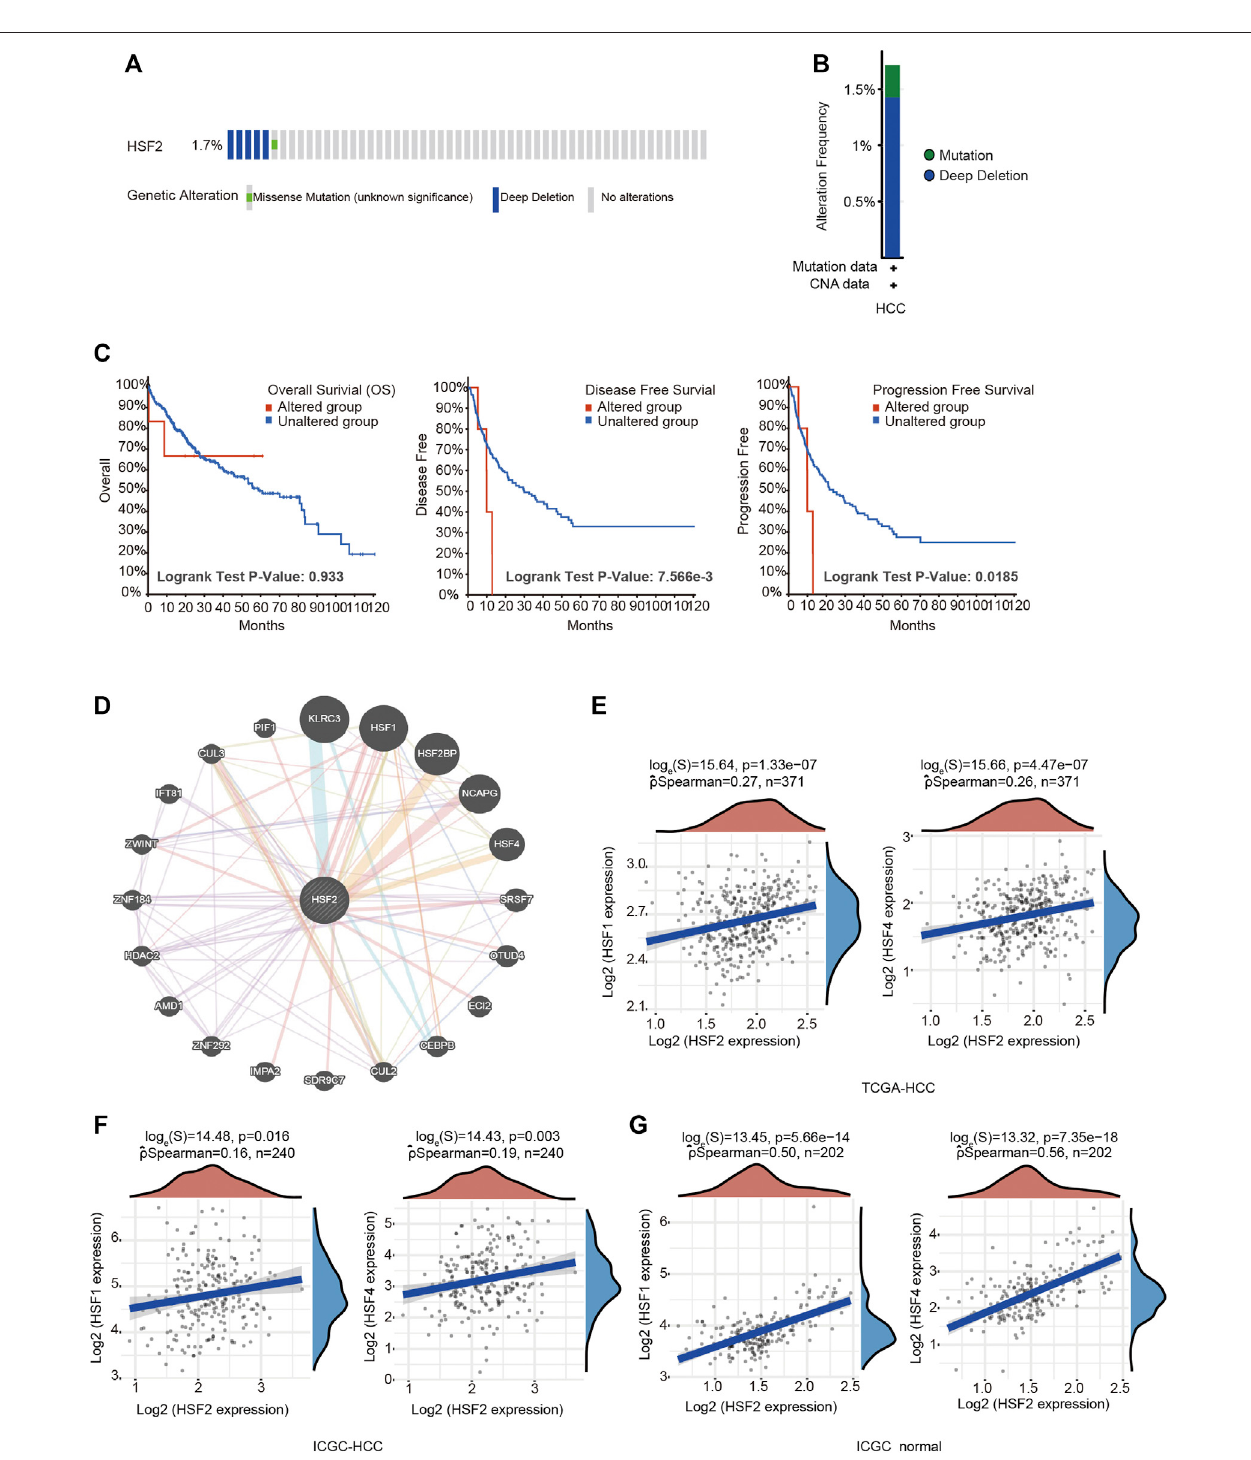
FIGURE5| Frequency ofHSF2alterationsandanalysisofneighboringgenenetworks inHCC. (A) OncoPrintvisualsummaryofalterations inaquery ofHSF2from thecBioPortaldatabase. (B) SummaryofHSF2genetic alterations inpatients withHCC. (C) Kaplan-Meier plotscomparing OS,DFSand PFSofpatients withor without HSF2 gene alterations. (D) The gene-gene interaction network of HSF2 was constructed using GeneMANIA. (E) Scatterplots show the correlations between HSF2 expression and HSF1 and HSF4 expression in the TCGA-HCC database ( n (cid:1) 371) using the R software package ggstatsplot. (F,G) Scatterplots show the correlations between HSF2 expression and HSF1 and HSF4 expression in HCC ( n (cid:1) 240) and normal liver tissues ( n (cid:1) 202) in the ICGC database using the R software package ggstatsplot.